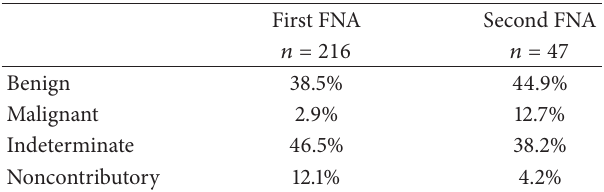
Table 4: Immunocytochemistry results for fine-needle aspirations